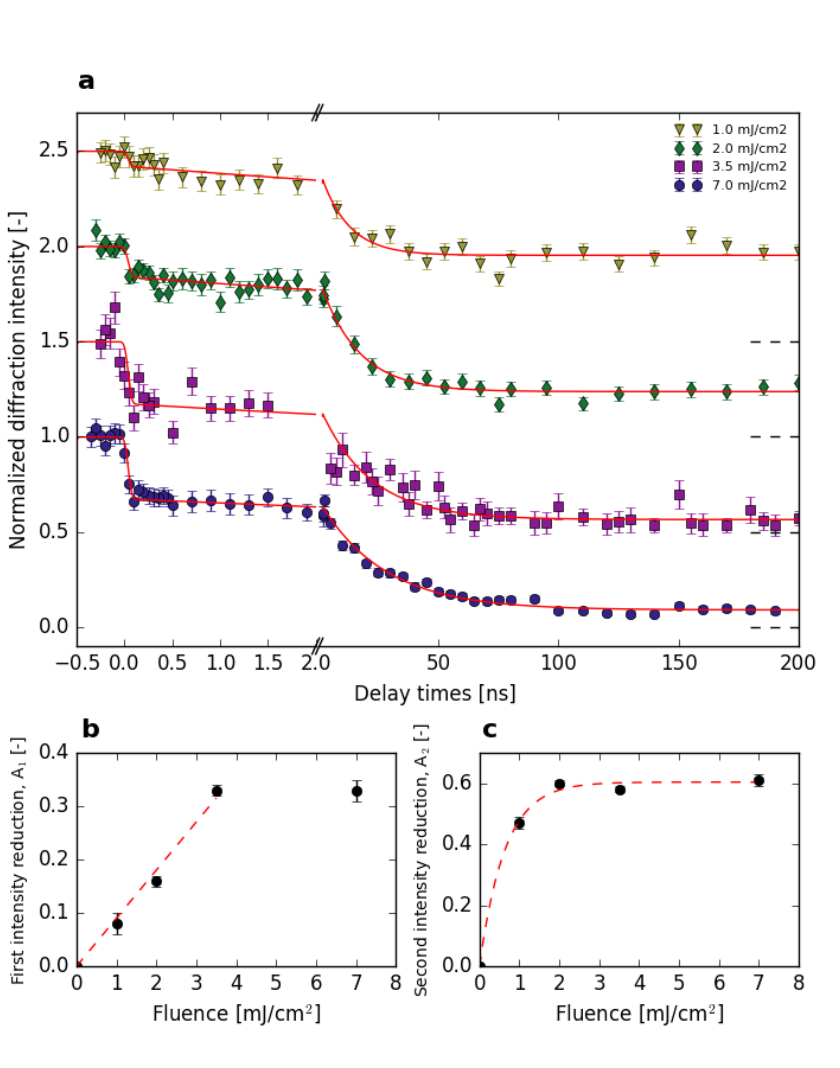
Figure 2. ( a ) Intensity of the superlattice reflection ( − 0.9 0.0 − 2.1) as a function of pump-probe delay for fluences (cid:72) , (cid:7) , (cid:4) , • = 1, 2, 3.5, 7 mJ/cm 2 , with a probing depth of 130 nm. Traces have been vertically offset for clarity. Red lines show the result of fitting the model described in the text to the data. ( b ) the amplitude of the first intensity reduction at intermediate times vs. fluence with a linear fit, and ( c ) the second at late times, with an exponential fit to guide the